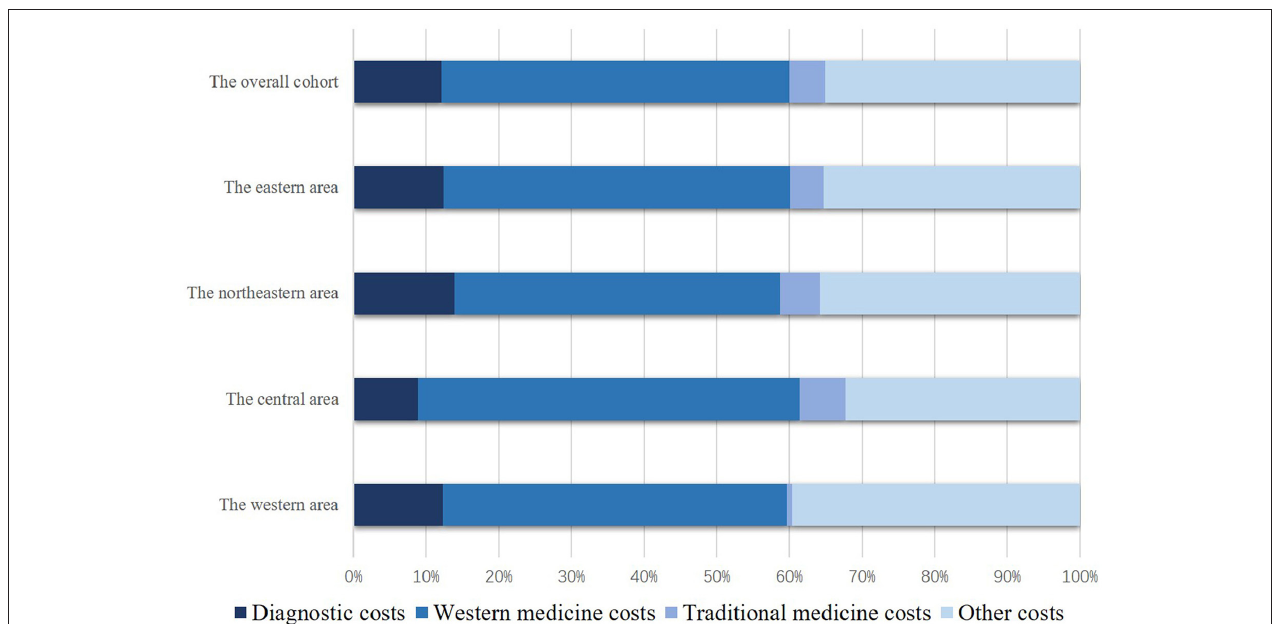
FIGURE 2 | Cost components of the different